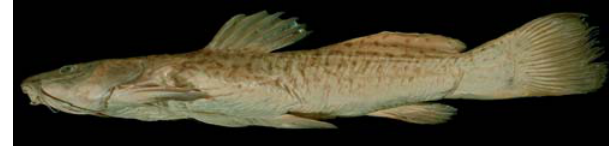
Fig. 4 . Lateral view of S. amblyurum syntype. MCZ 7324, 380 mm SL, rio Jequitinhonha, along Jequitinhonha valley, Minas Gerais,